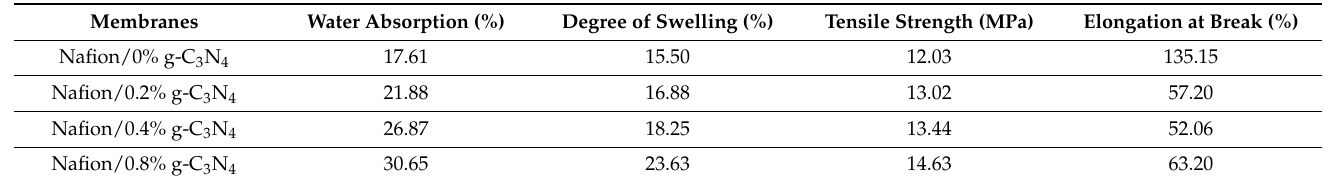
Table 1. Water absorption, degree of swelling, and mechanical properties of the Nafion/ g-C 3 N 4 modified membranes.